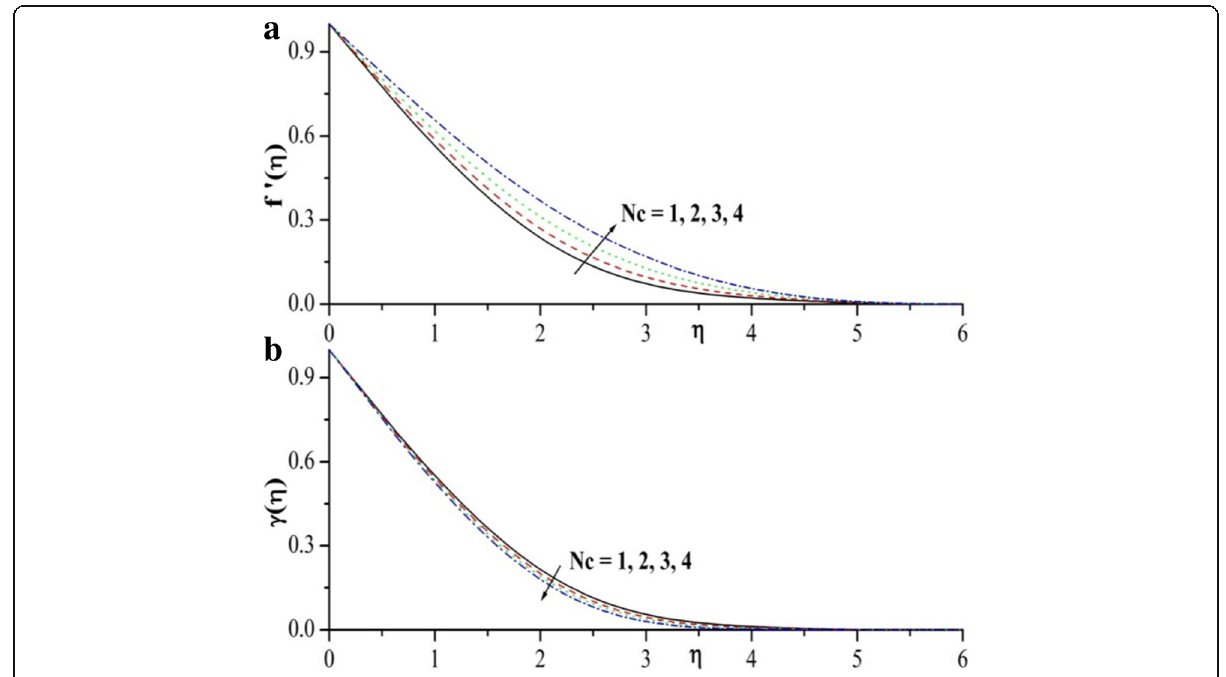
Fig. 2 a Velocity and b solute concentration profiles for variable values of Nc